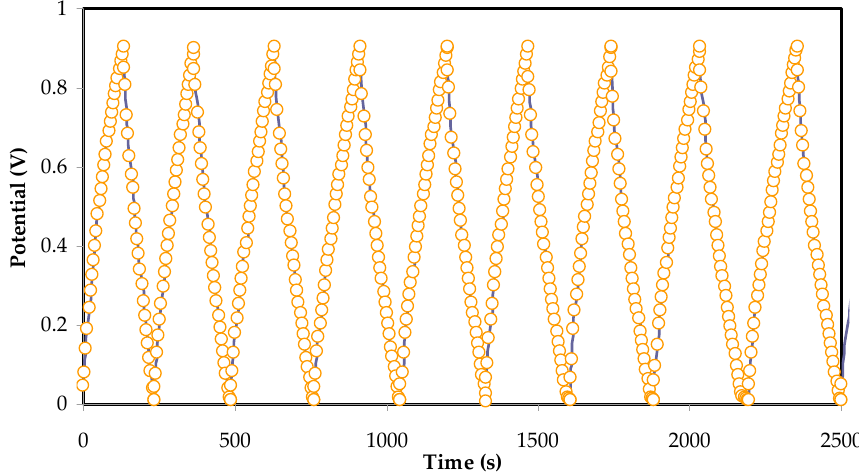
Figure 8. Selected charge–discharge graphs of the EDLC at 0.5 mA/cm 2 . Figure 8 . Selected charge–discharge graphs of the EDLC at 0.5 mA/cm 2 . Figure 8 . Selected charge–discharge graphs of the EDLC at 0.5 mA/cm 2 .